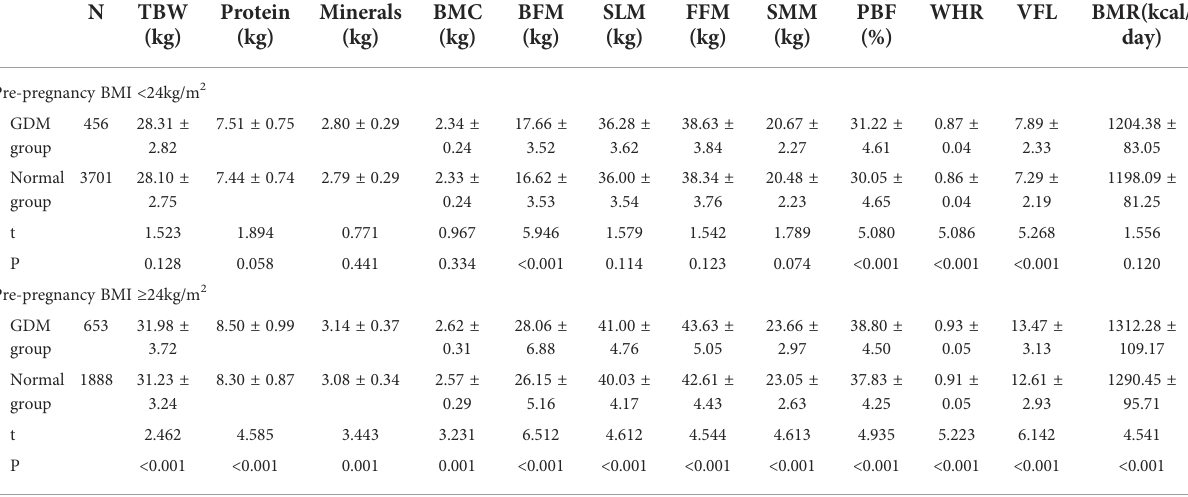
TABLE 3 Analysis of body composition of pregnant women under different pre-pregnancy BMI.